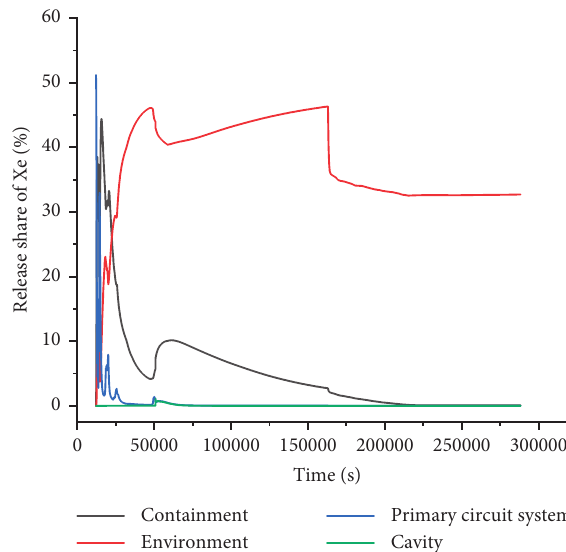
Figure 19: Distribution of Xe in different